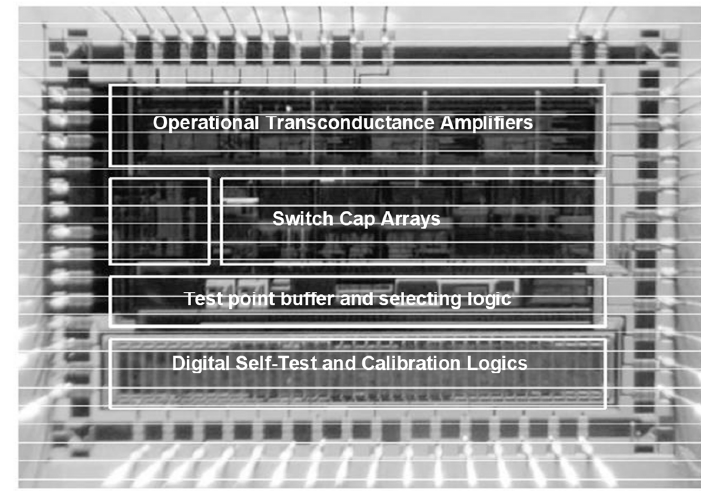
Figure 5. The micro − photograph of the die of the ASIC.